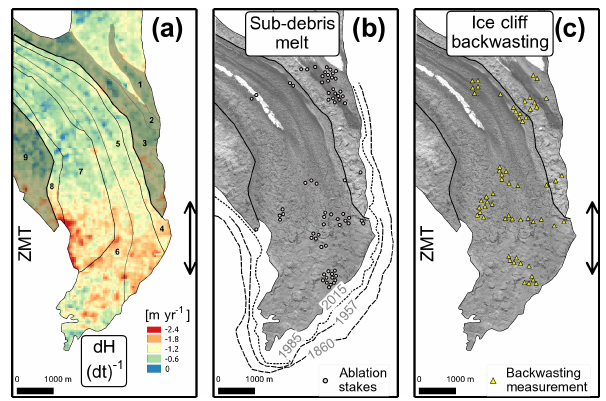
Figure 4. The study area with defined medial moraines and in situ measurement locations. This map of the study area includes the bare ice parts of Root Glacier, which are excluded and masked when making distributed melt estimates. The area defined by the nine me- dial moraines in panel (a) is used for distributed melt estimates. (a) Glacier thinning data from 1957 to 2004 (Das et al., 2014). This panel uses the same data as in Fig. 1c but the medial moraines are defined. The shaded medial moraines are treated differently for dis- tributed debris thickness estimates (see Sects. 2.3 and S3.1). Note that medial moraines 4 through 8 contain the majority of the zone of maximum thinning. Medial moraines 3 and 9 show much thicker debris at the same elevation than the others (Fig. S14). The zone of maximum thinning (ZMT) is shown by the double-headed arrow. (b) Sub-debris melt rate measurement locations. Debris was mea- sured at all locations in (b) and (c) ; in some cases ice cliffs and sub-debris measurements were proximal and only one debris thick- ness measurement was made between them. The five central medial moraines are within the two black lines, within which 69% of de- bris thickness measurements were made. (c) Locations where ice cliff backwasting rate was